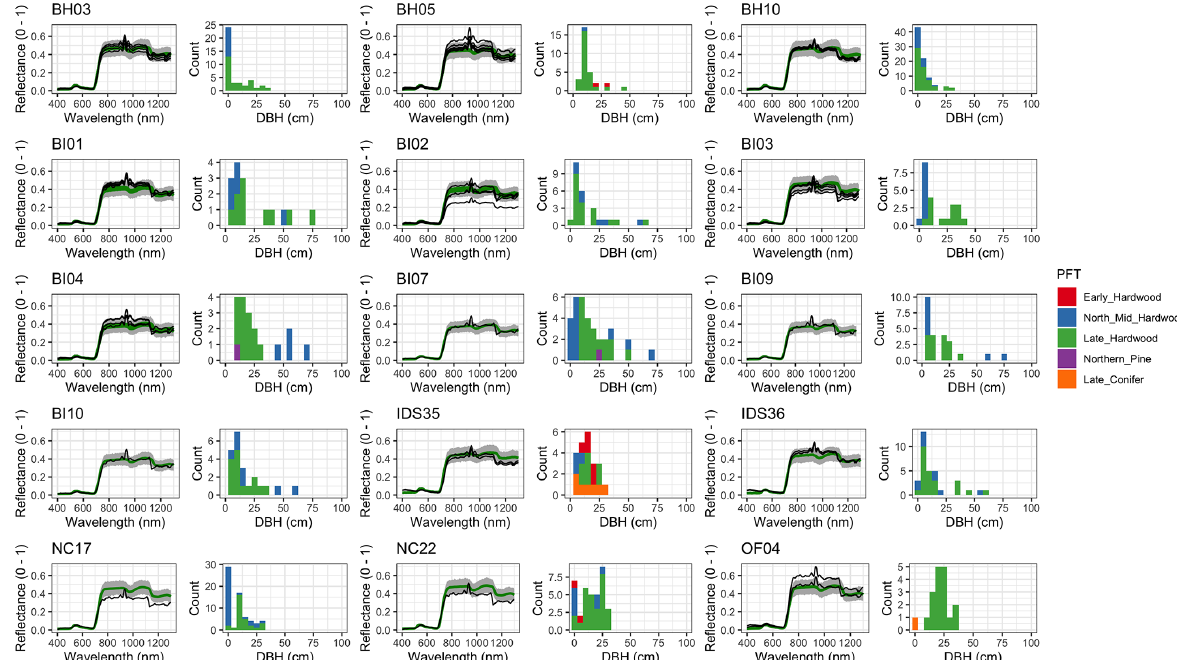
Figure A13. As above but for sites where late hardwood trees had the largest mean DBH.